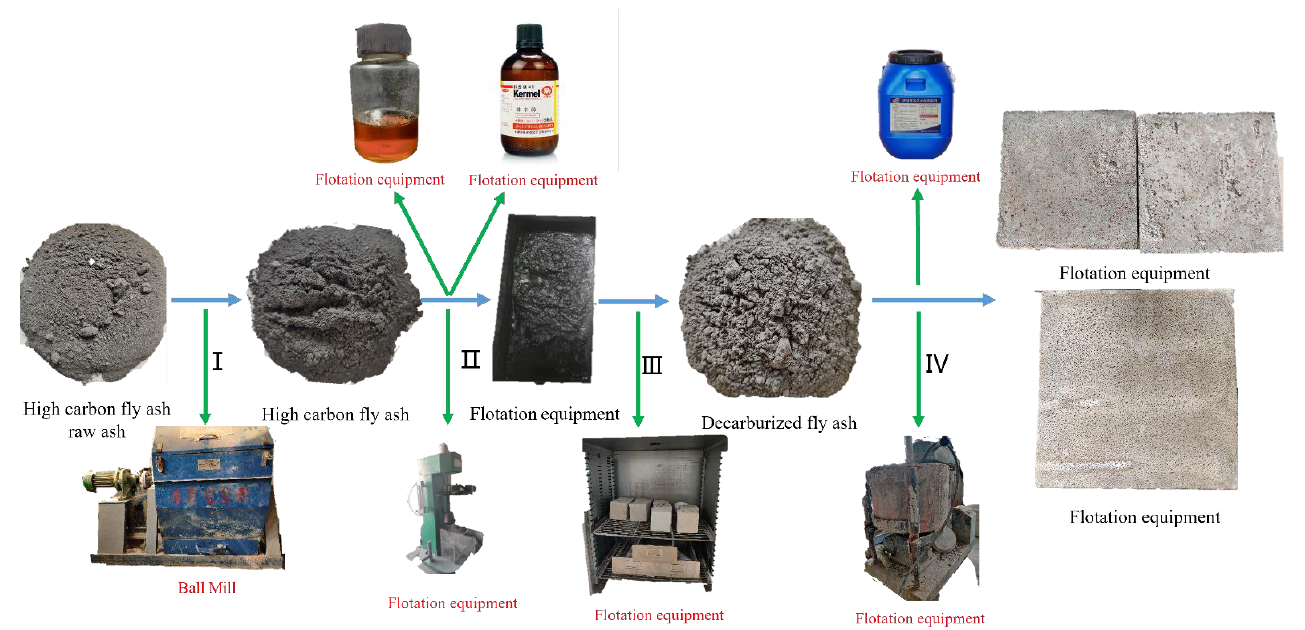
Figure 4. High carbon fly ash mechanical activation-flotation process and the preparation process of foam concrete.